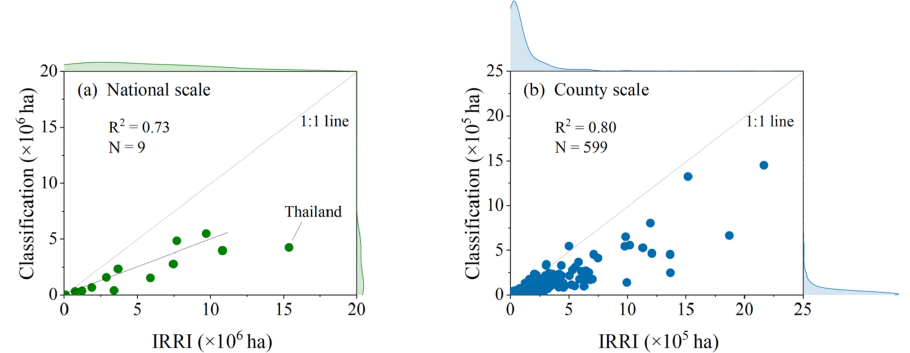
Figure 6. Comparisons between the paddy rice area in our study and IRRI dataset in SE Asia at the (a) national and (b) county levels. The marginal kernel density plot above or to the right of each scatterplot shows the distribution of the data in one dimension.